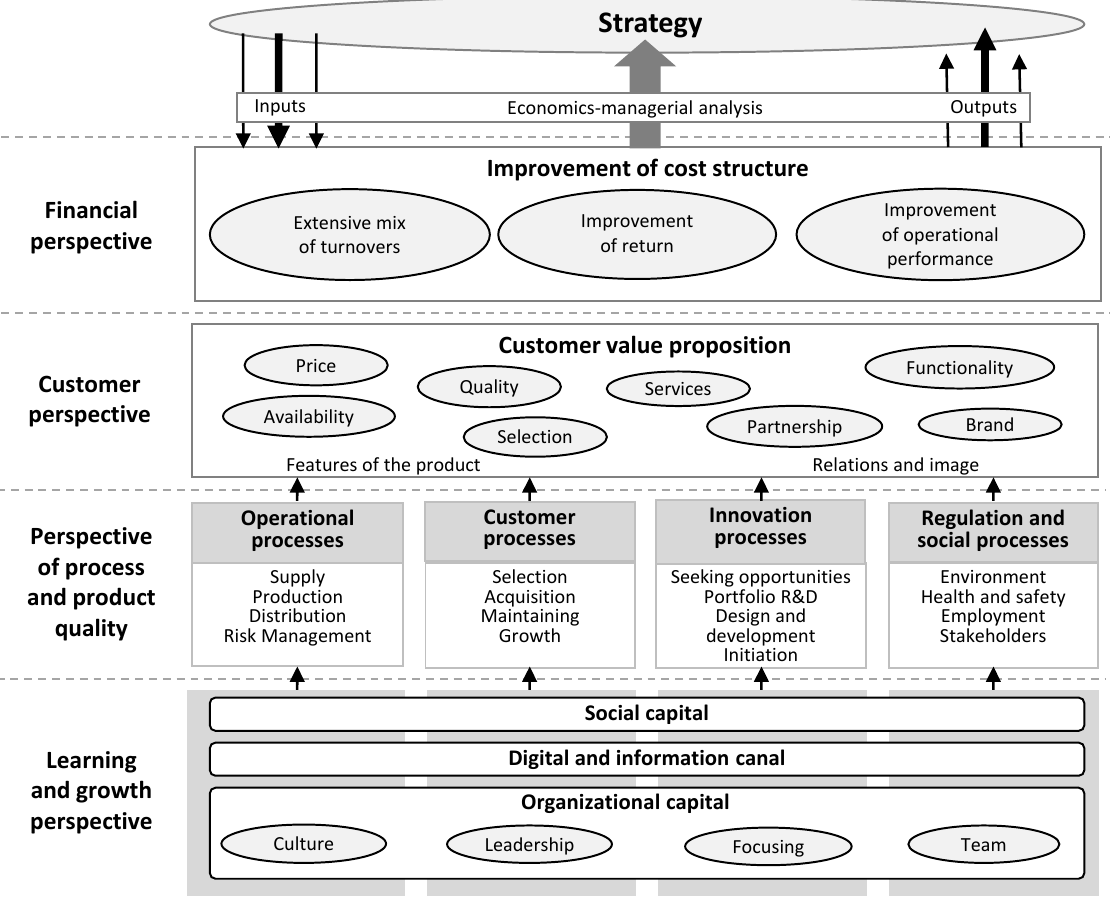
Figure 5. Strategies for enterprises in the network of suppliers in the automotive industry